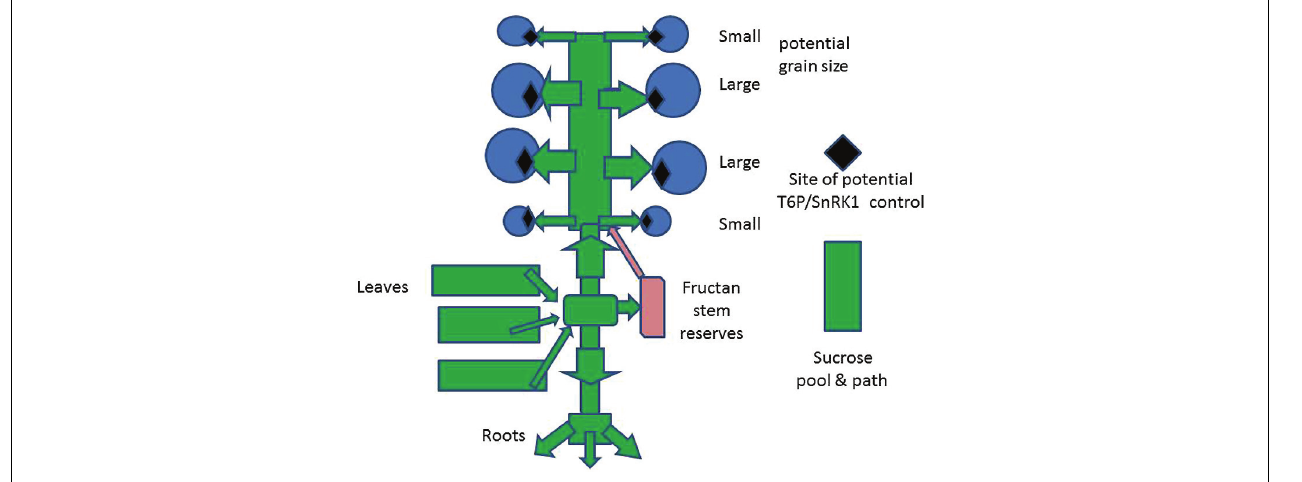
FIGURE 2 | Schematic of the source–sink relations of a wheat plant and the potential sites for modification ofTRE/SnRK1 metabolism to increase potential grain size.